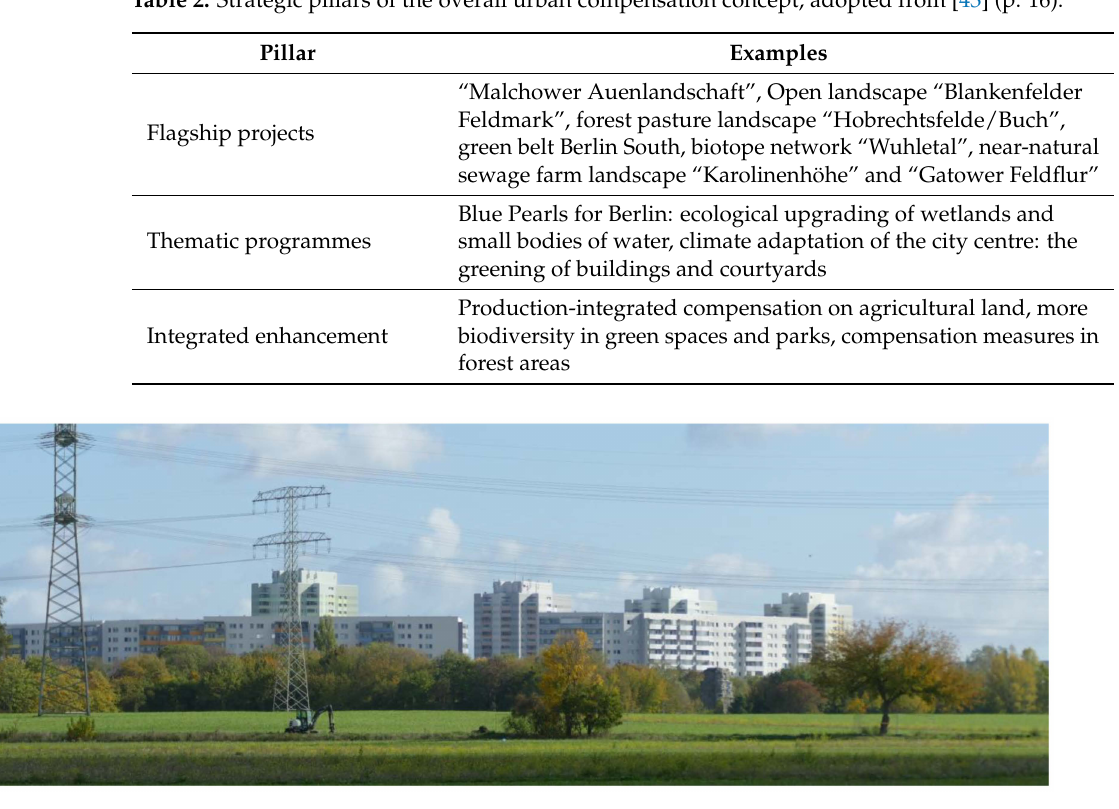
Figure 2. Eco-account subarea “Südliche Feldflur” in the vicinity of the urban quarter “Neu- Hohenschönhausen” (October 2022, G.F.M.